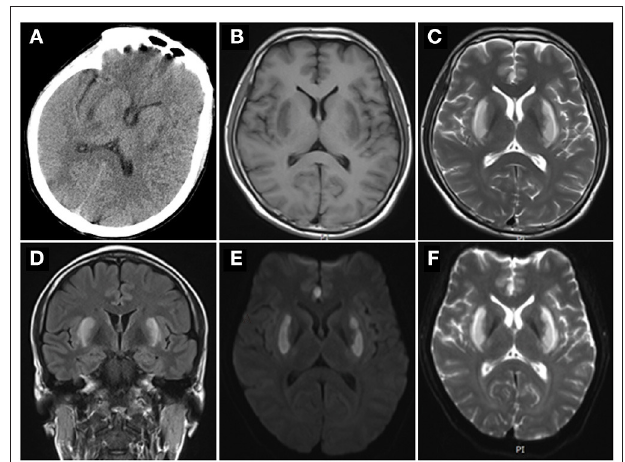
FIGURE 1 | Brain images. (A) CT scan showed bilateral symmetric basal ganglia low density. Brain MRIs showed low signal intensities in the bilateral symmetric putamen in T1 (B) , and high signal intensities in T2 (C) , Axial FLAIR (D) , diffusion weighted image (E) , apparent diffusion coefficient (F) over the same regions.